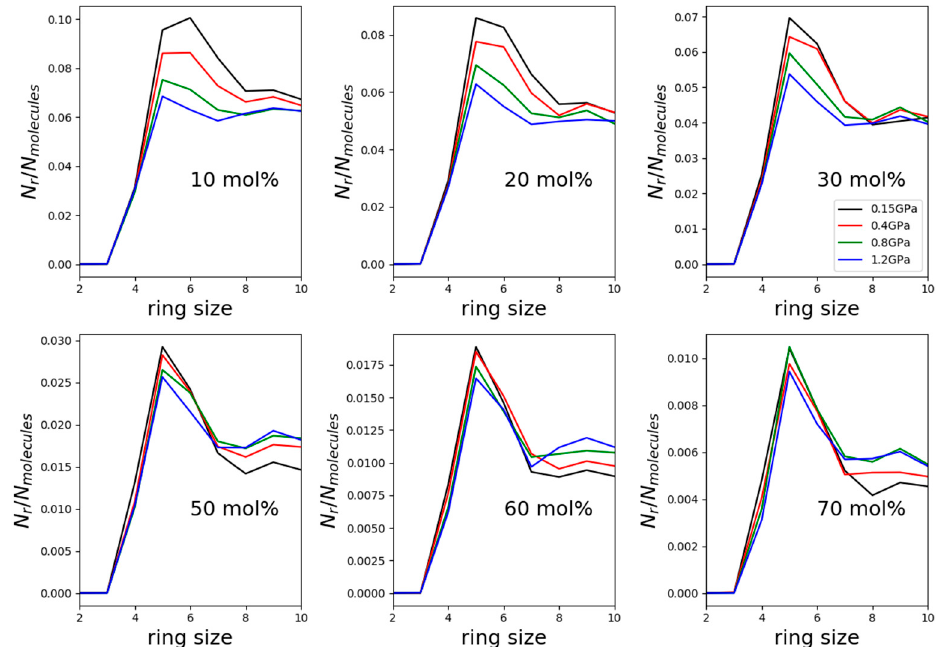
Figure 6. Primitive hydrogen-bonded rings, as represented by the ratio of molecules that participate in small ring-like structures, in computer models of water–methanol mixtures as a function of pressure. Black lines: 0.15 GPa; red: 0.4 GPa; green: 0.8 GPa; blue: 1.2 GPa. Note that the number of cyclic structures fell by one order of magnitude as methanol concentration grew from 10 to 70 mol%.